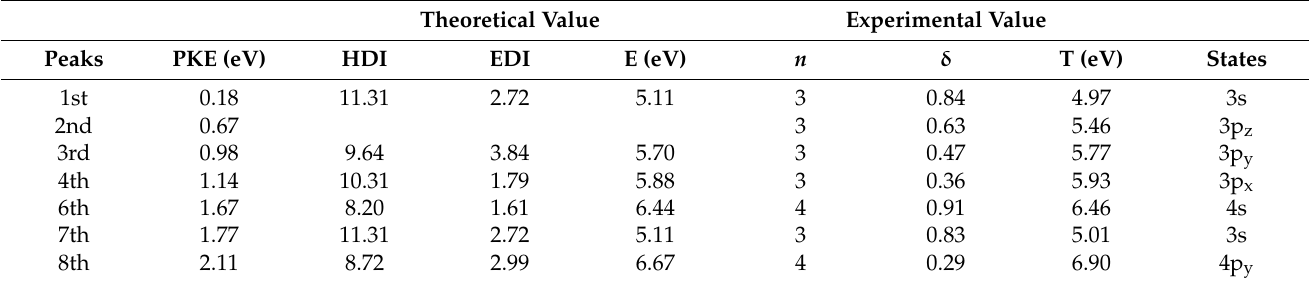
Table 2. Theoretically calculated molecular hole delocalization index (HDI), electron delocalization index (EDI), and Rydberg energy (E), and experimentally obtained Rydberg excitation energy (T). The E represents the theory calculated value, and T is the Rydberg excitation energy calculated according to Equation (3) for the experimental data. The theoretical method is used the basis set DFT and